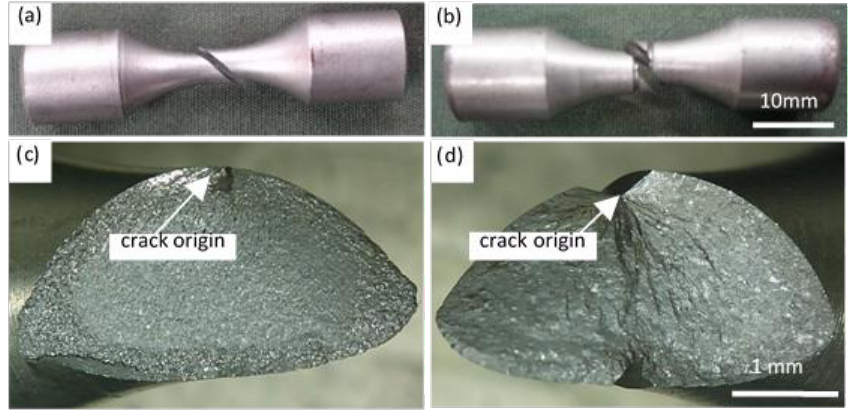
Figure 7. Appearance of fractured ( a , c ) smooth and ( b , d ) notched specimens of carburized and fine particle peened TM steel. ( a ): N f = 4.94 × 10 6 cycles, ( b ): N f = 1.67 × 10 6 cycles.